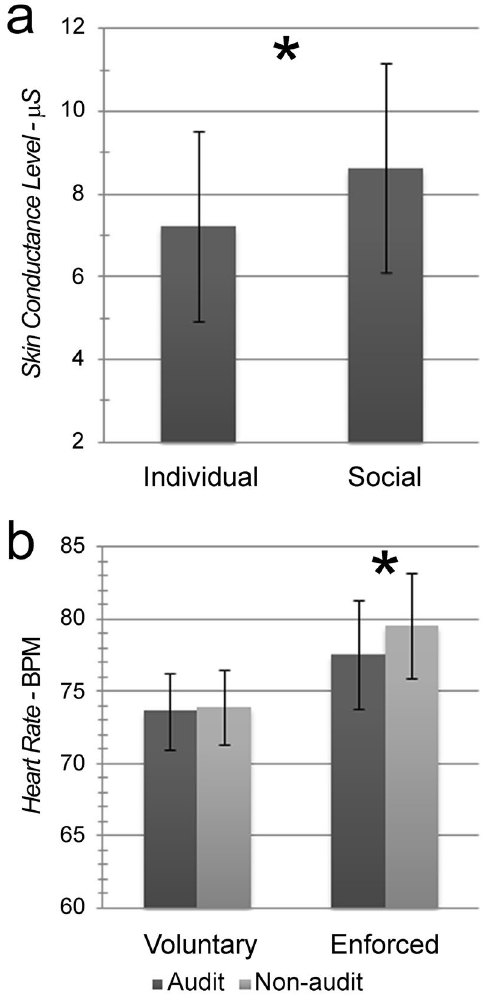
Figure 2. Autonomic activity during the feedback phase. Bars represent ± 1SE; the star marks statistically significant differences. ( a ) Significant modulation of Skin Conductance Level measures depending on the experimental condition: Individual vs . Social. ( b ) Modulations of Heart Rate measures depending on the tax- compliance style – Voluntary vs . Enforced – and on the presence vs . absence of a fiscal